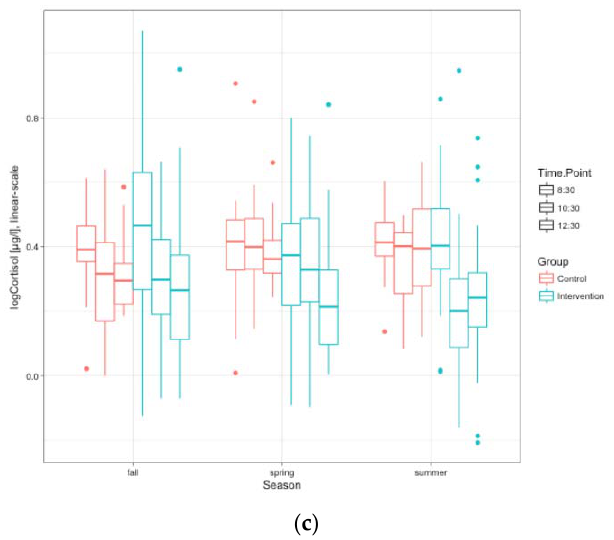
Figure A1. Cortisol raw values compared to log10-transformed cortisol values. Displayed are ( a ) the raw cortisol values on the three time-points (8:30, 10:30, 12:30) at the three seasons (fall, spring, summer) in both groups (control = red, intervention = green). Panel ( b ) shows the same data with a logarithmized y-axis and ( c ) the logarithmized cortisol-values on a linear y-scale. It can be seen that by log-transforming the y-scale ( b ), some outliers can be eschewed, and that by logarithmizing the cortisol-values ( c ), the variance, skewness, and kurtosis of the data can be reduced (c.f. Table A1). Table A2. Descriptives for logCortisol and Cortisol.